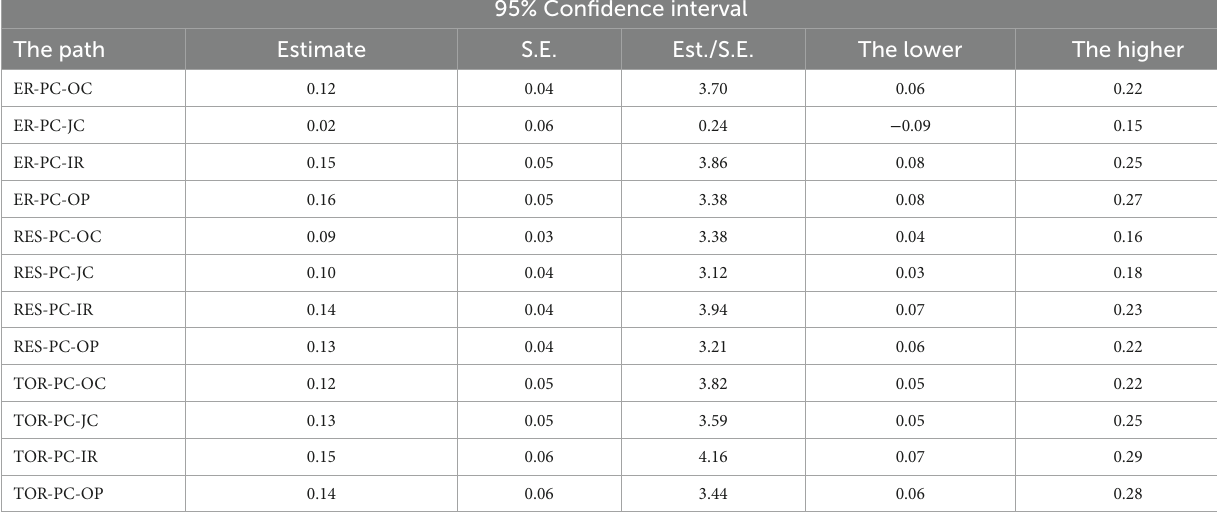
TABLE 8 Mediating effect